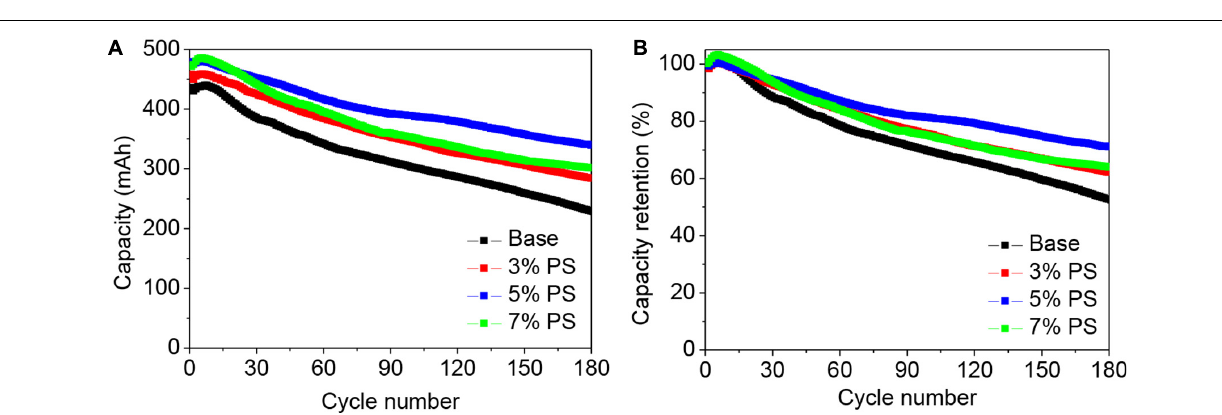
Frontiers in Materials |